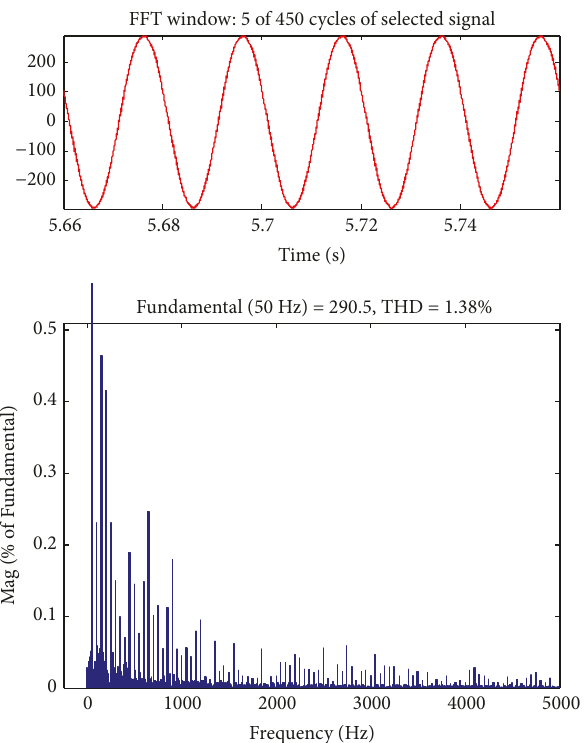
Figure 19: Three-phase grid-side current THD at 5s.